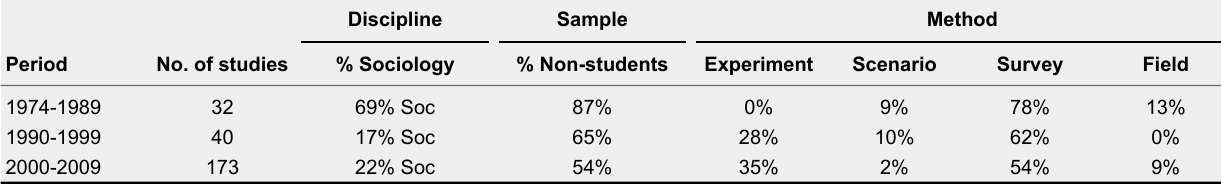
Paradigmatic development of the social psychology of protest from 1974-2009: Methods